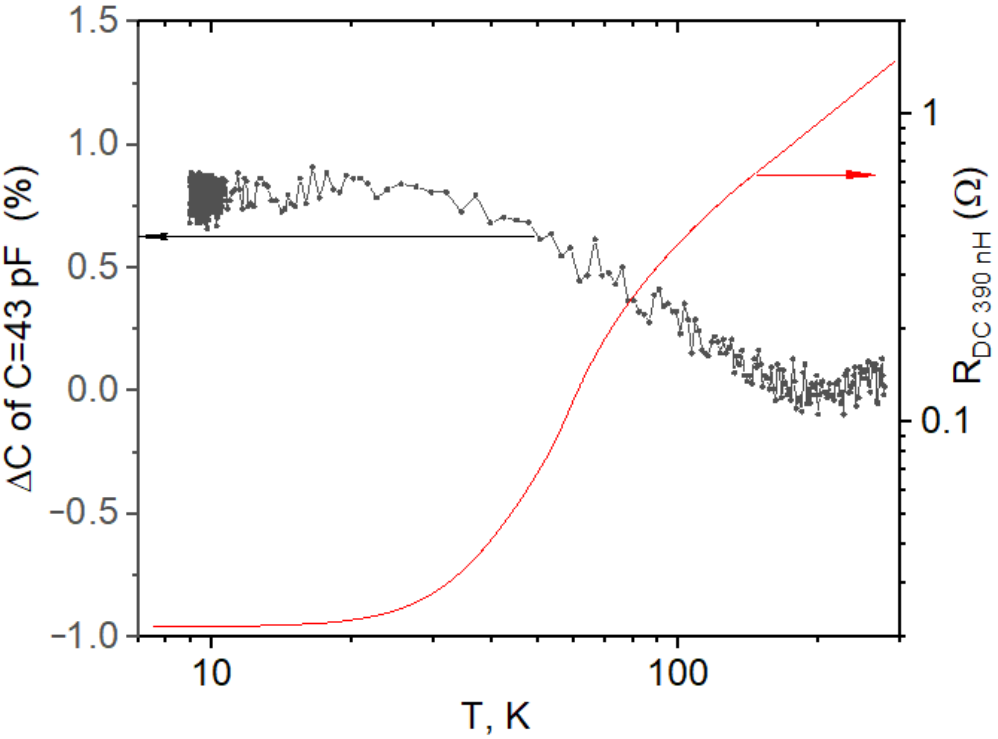
Figure 5. Temperature dependence of the DC resistance of the 390 nH Coilcraft 0805 inductor (red) and 43 pF Johansson technology capacitor (black).